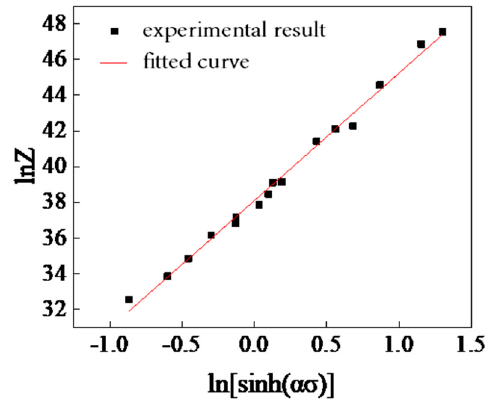
Figure 8. The relation curve of ln Z − ln [ sinh ( ασ )] .